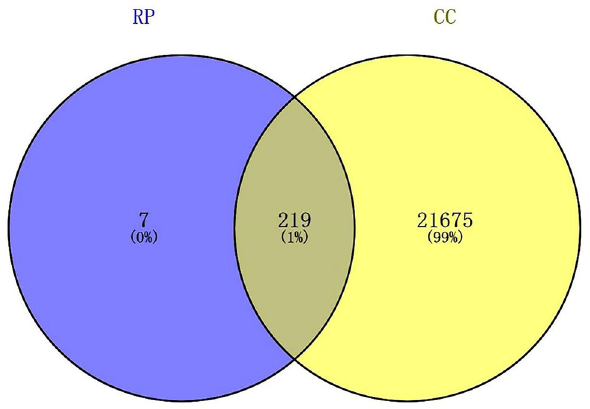
Figure 2. Venn diagram of RP and colon cancer, with 201 overlapping targets.